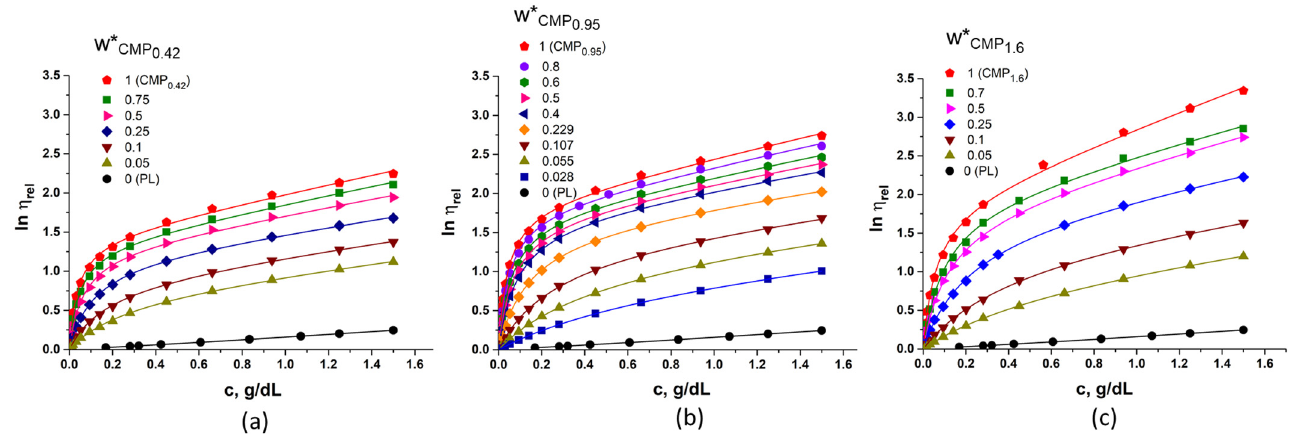
Figure 2. The dependence of ln ( η rel ) on c for PL/CMP 0.42 ( a ), PL/CMP 0.95 ( b ) and PL/CMP 1.6 ( c ) in water at 37 °C for different compositions of polymer mixtures. The lines represent the fitting curves according to Equation (1).